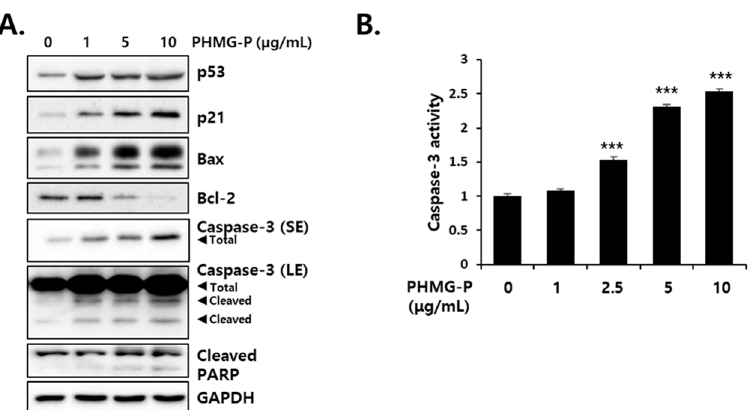
Figure 4. The effect of PHMG-P on the levels of apoptosis-related proteins and caspase activity in HepG2 cells. ( A ) The cells were treated with PHMG-P at 1, 5 and 10 µg/mL for 16 h. Western blotting analysis was performed using specific antibodies against the indicated proteins. GAPDH was used as a loading control. ( B ) Cells were treated with PHMG for 6 h and caspase-3 activity was determined using a fluorometric substrate. The results are presented as the mean ± SD of triplicate experiments. SE: short exposure, LE: long exposure. (*** p < 0.001 compared with vehicle-treated cells).